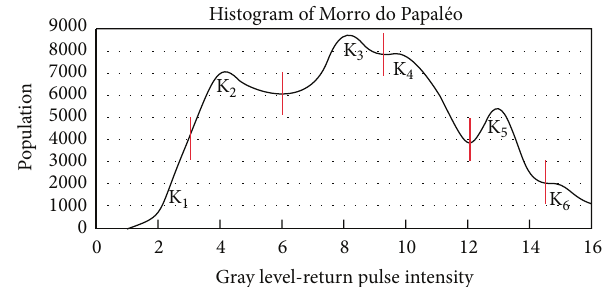
Figure 10: Histogram from the return intensity values from the MorrodoPapal´eooutcrop.Theredverticallinesseparatetheclusters that were user-defined and applied in the K-Clouds